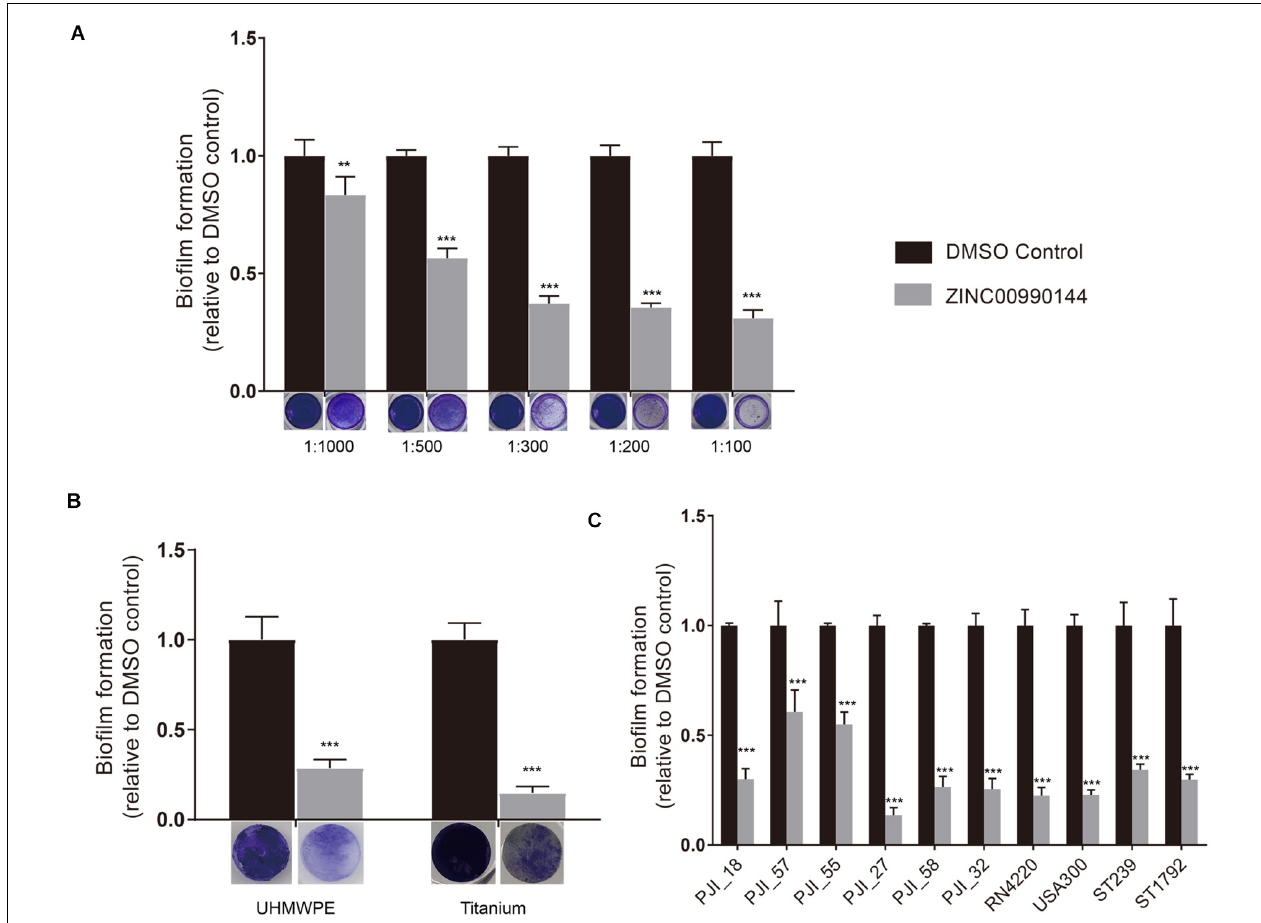
FIGURE 2 | Concentration gradient of ZINC00990144 on the inhibition biofilm formation (A) . Biofilm inhibition potency of ZINC00990144 on different materials (B) and against different S. aureus strains (C) . (A) The significance of biofilm inhibition increased with the increment of concentration in strain USA300. Biofilm was stained with crystal violet and quantified by measuring 590 nm absorbance. Dilution ratio is relative to storage solution. (For example: 1:1000 represents 2.3 µ M compound or 0.1% DMSO). (B) USA300 biofilm formation on UHMWPE and titanium are significantly prevented by ZINC00990144 administration at the concentration of 11.5 µ M (dilution ratio 1:200). Representative gross image of UHMWPE and titanium implant are shown under the x -axis. (C) ZINC00990144 at concentration of 11.5 µ M is effective to all of the S. aureus isolates we tested. Biofilm was quantified with crystal violet staining method. ** P < 0.01, *** P < 0.001 comparing to DMSO